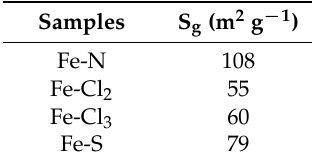
Figure 4. Raman spectra of thermally treated Fe-lignin samples prepared using different iron sources as catalysts: Fe-N ( a ), Fe-Cl 3 ( b ), Fe-Cl 2 ( c ) and Fe-S ( d ).